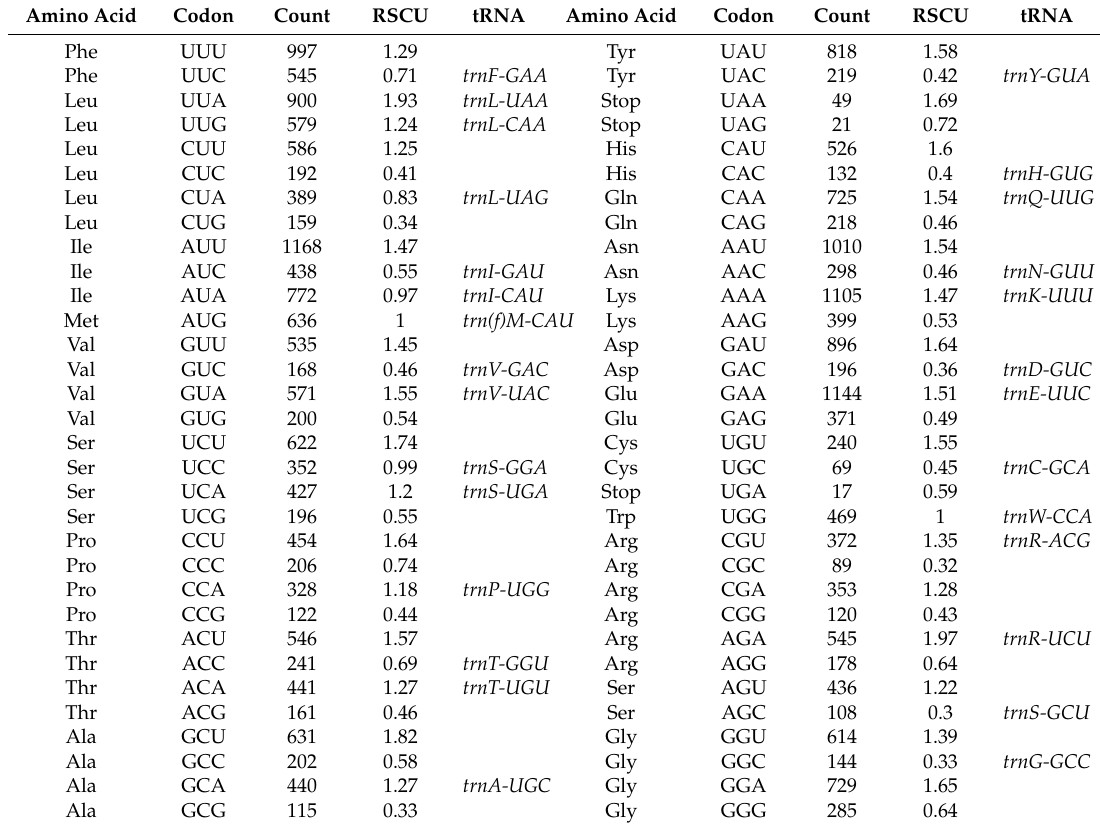
Table 2. Codon–anticodon recognition patterns and codon usage in the A. kravanh chloroplast